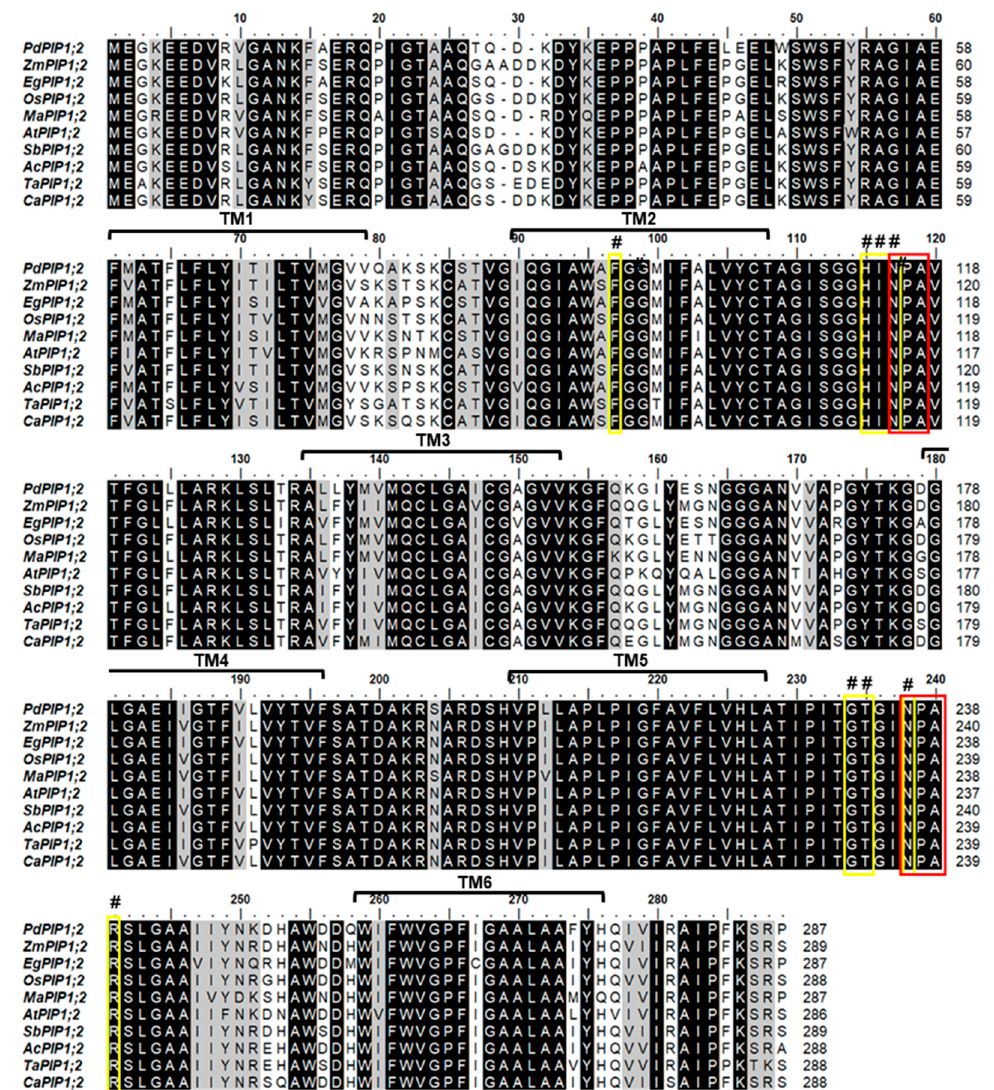
Figure 2. Mapping of conserved domains on PdPIP1;2 . The multiple sequence alignment of the deduced amino acid sequence of PdPIP1;2 and other PIP1;2 isoforms from other plant species. The dark-colored highlight shows the identical/conserved regions and the gray highlights show similar regions with a one amino acid difference. The yellow boxes with the (#) sign refer to the eight amphipathic channel residues while the red boxes show the conserved Asn-Pro-Aln motif signature of major intrinsic protein (MIP) family. Six transmembrane ™ domains are represented on the sequence alignment.